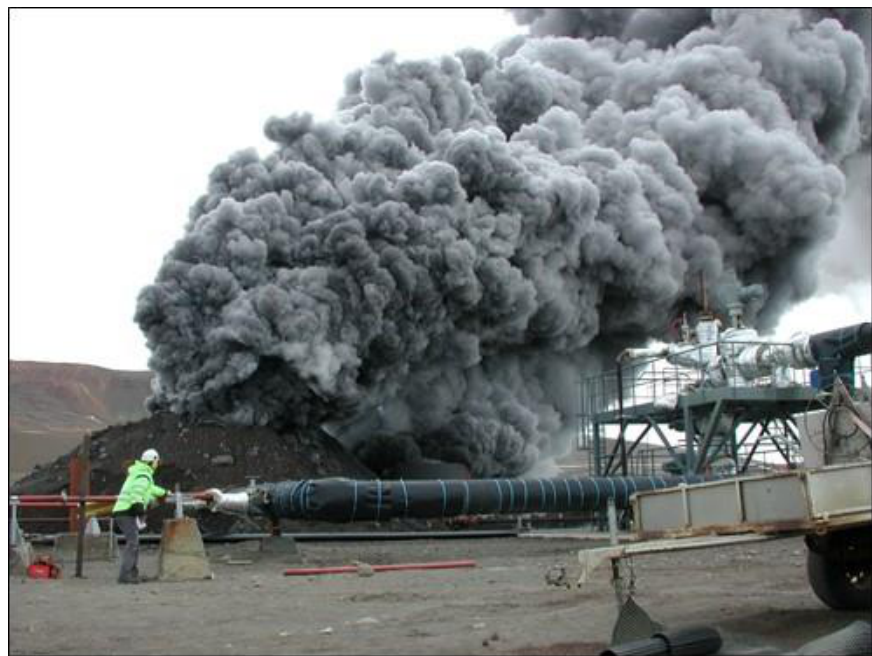
Figure 17. The beginning of a flow test of IDDP-1 (photo G. Ó . Friðleifsson).